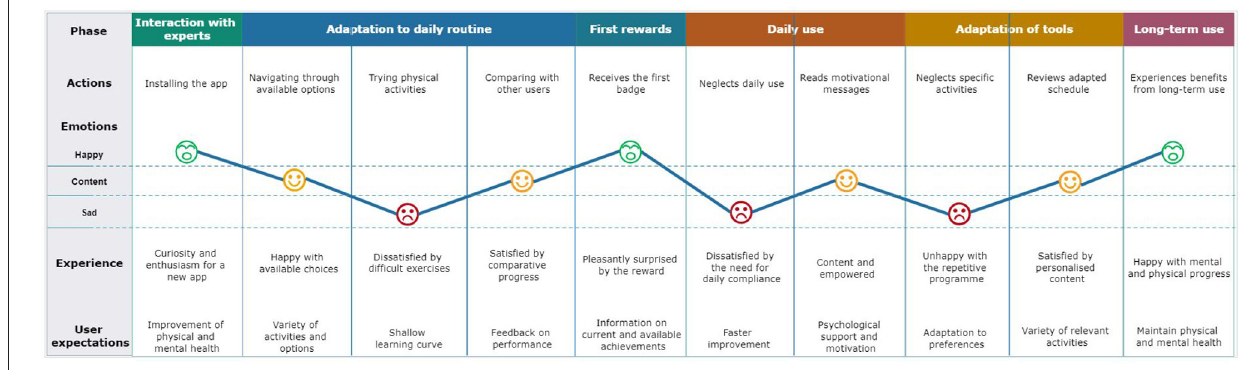
FIGURE 5 | Predicted user journey for the MediLudus app.